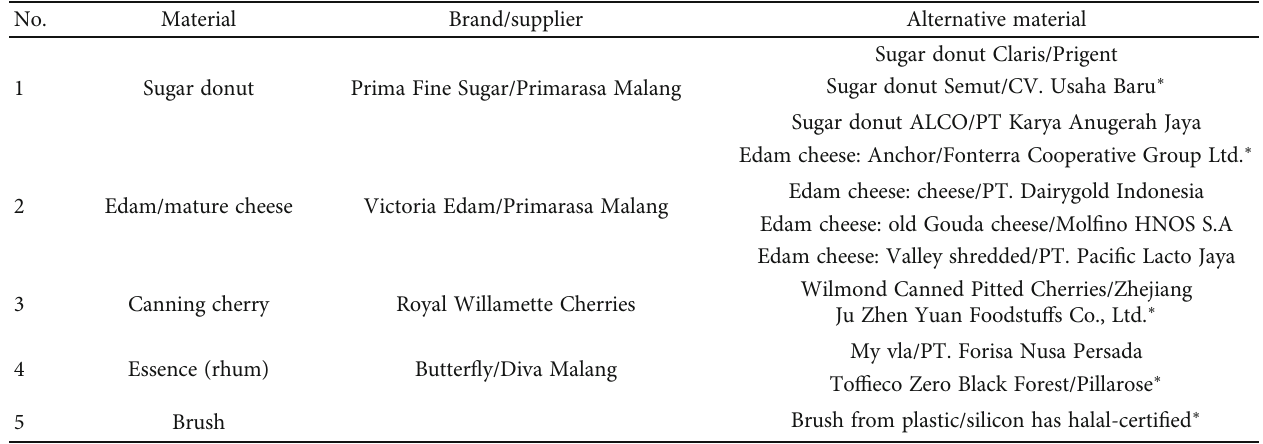
Figure 5: Internal audit results of critical activity procedures. Yes: under the state of the bakery business; No: not according to the state of the bakery business. Table 5: Alternative replacement of materials and